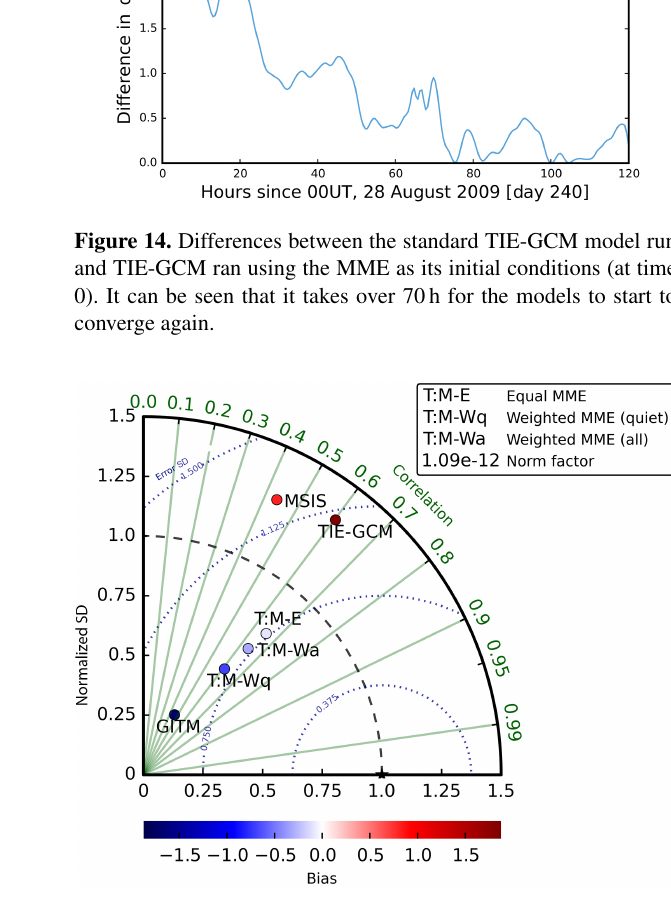
Figure 15. Modified Taylor diagram for NRLMSISE-00 (MSIS), TIE-GCM, GITM, and for TIE-GCM using the MMEs (equal, quiet-time weighted, and all-time weighted) for its initial conditions every 6h, compared with the CHAMP observations. Details of how to read the diagram are described in Fig.